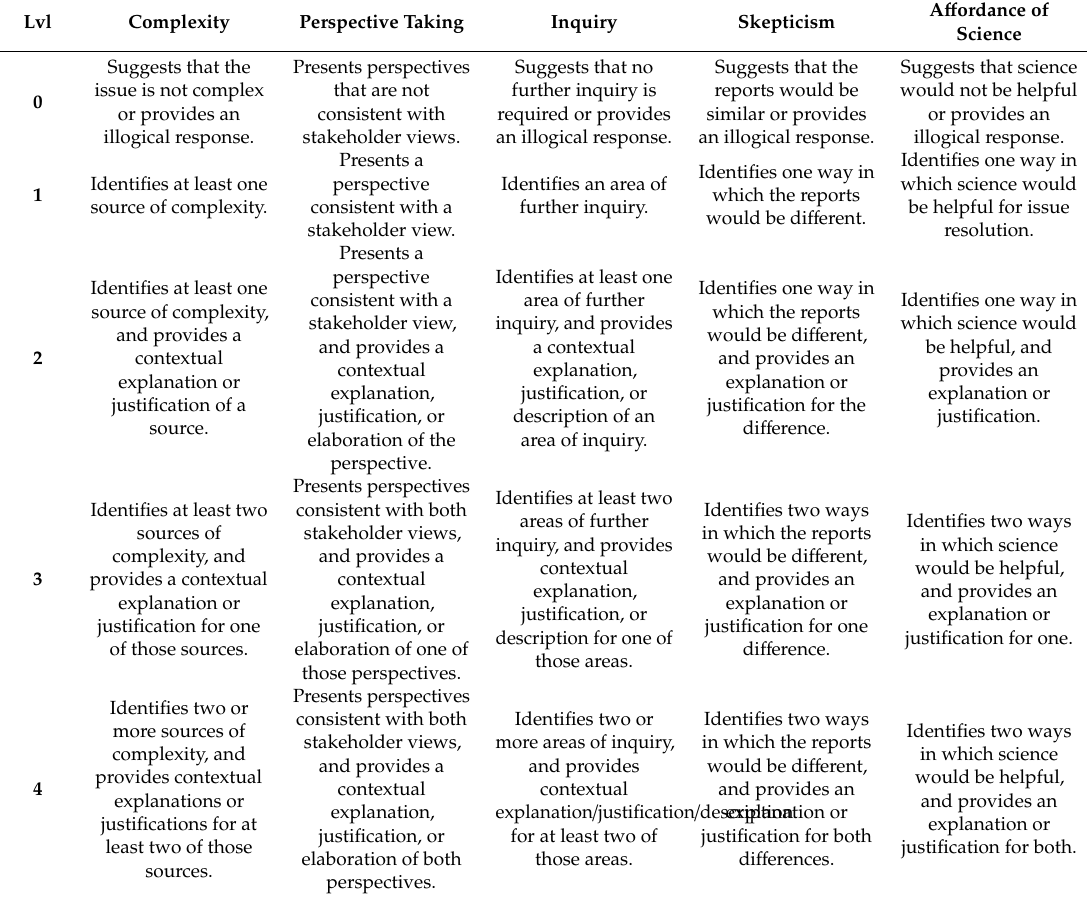
Table A1. Depth of SSR